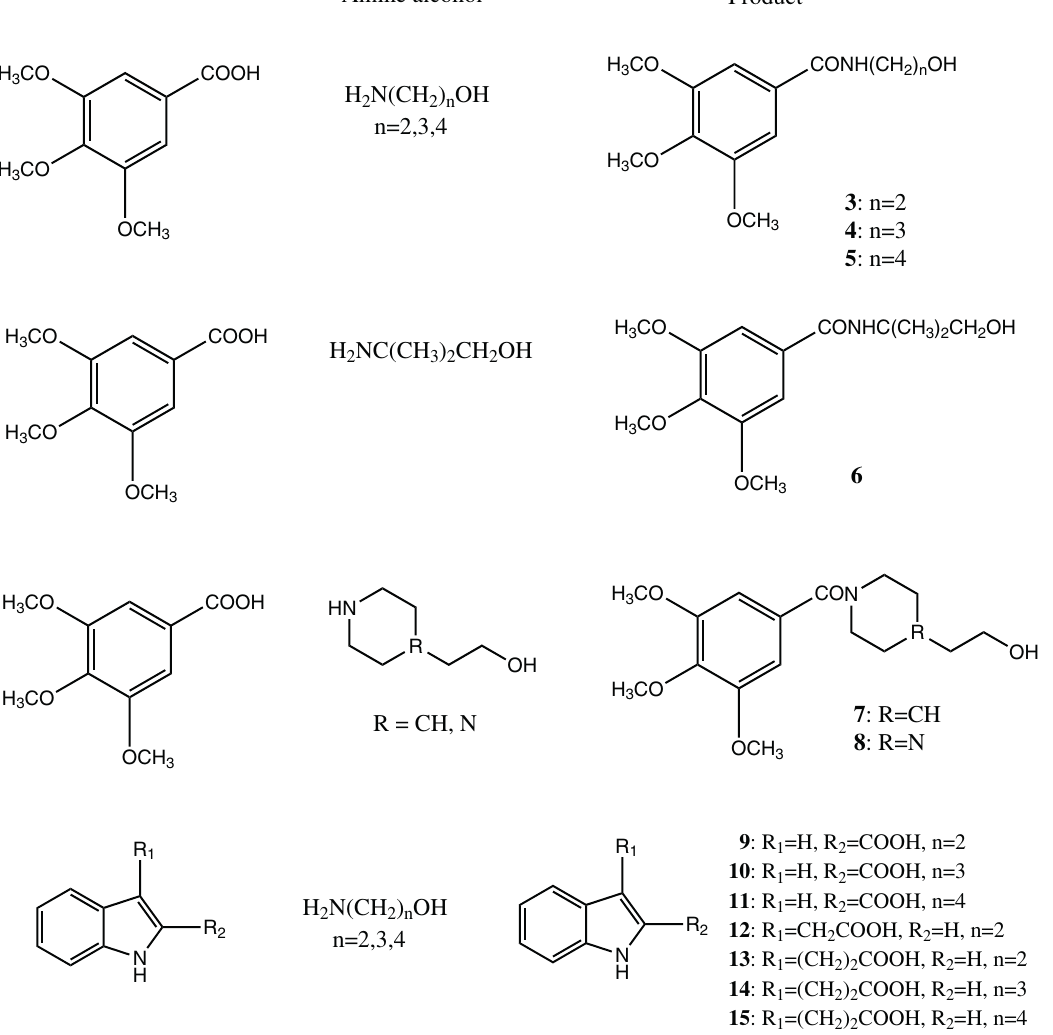
Figure 2 - Structure of acids, amino alcohols and hydroxyl amides 3-15